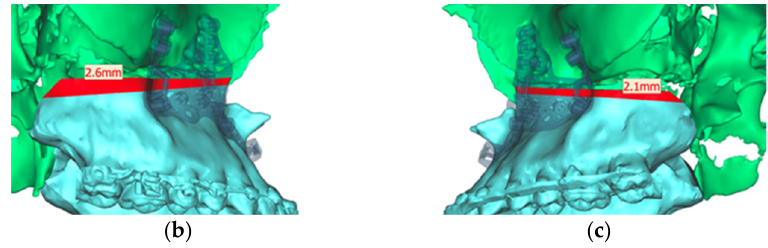
and representation of the deviation of the osteotomy lines from the planned course in mm (red). ( a )